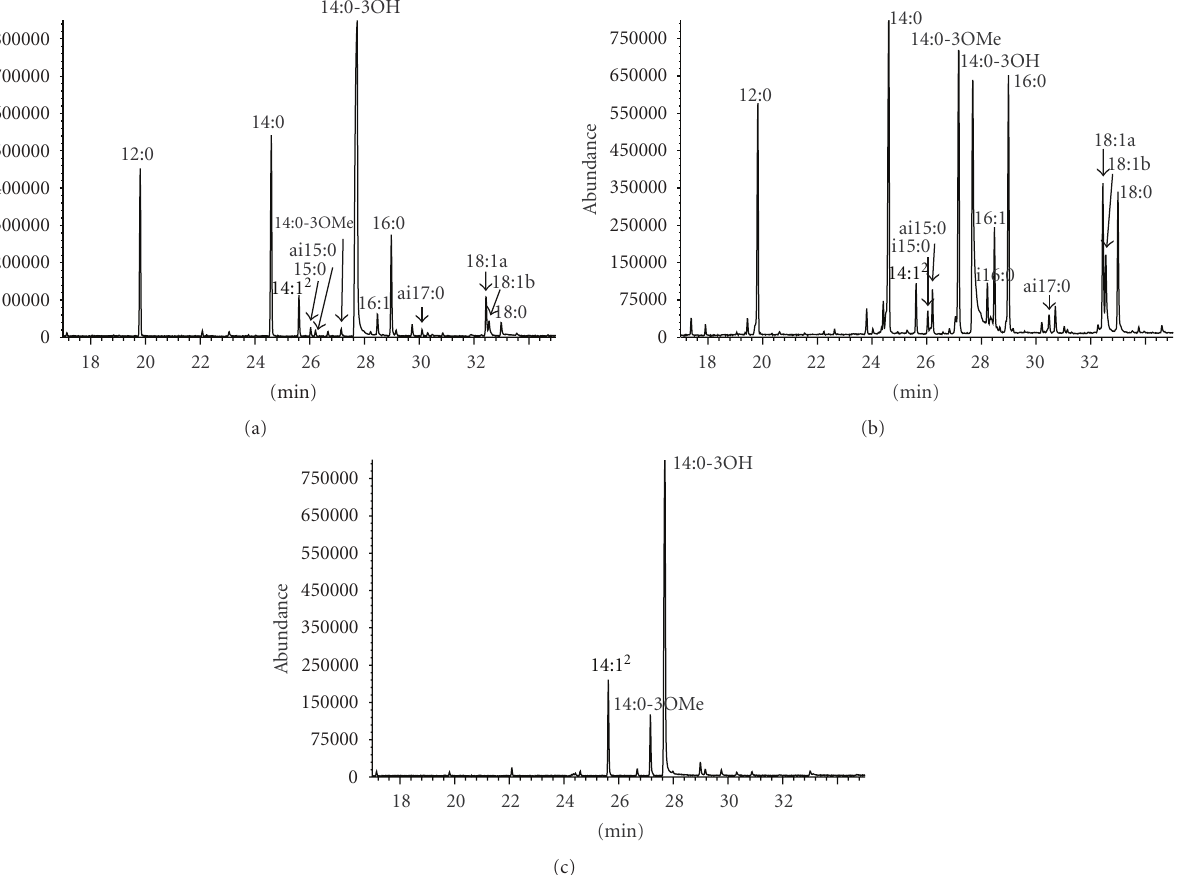
Figure 4: Chromatogram of methyl derivatives of fatty acids being the constituents of D. desulfuricans LPS (a) total fatty acids, (b) ester- bound fatty acids, (c) amide-bound fatty acids).